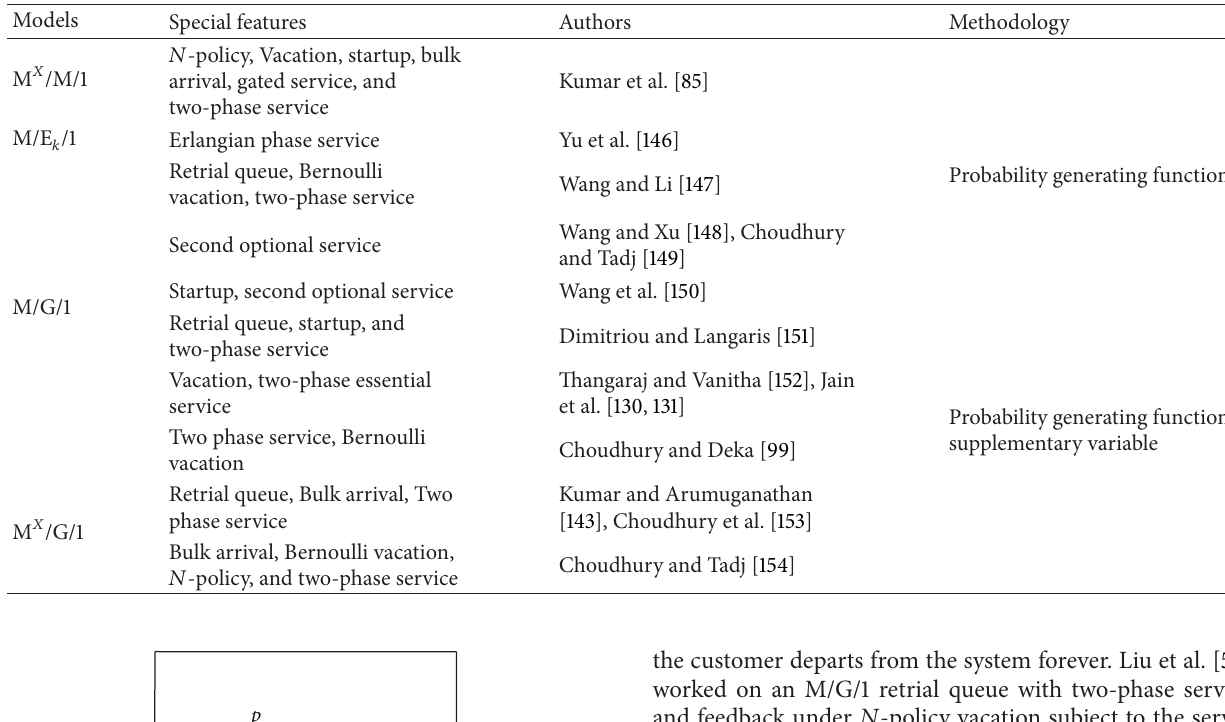
Table 4: Literature on unreliable server queue with phase service.